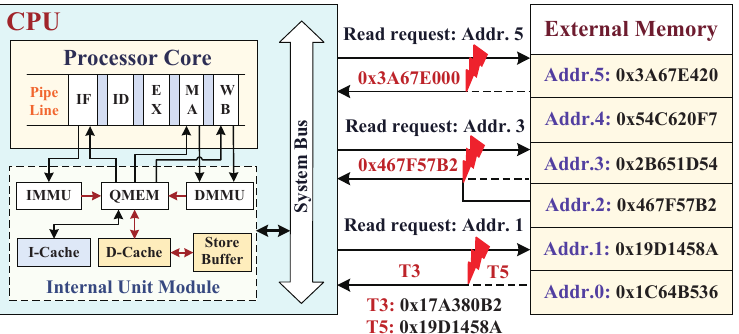
Figure 2. External data tampering attacks: spoofing attack, relocation attack, and replay